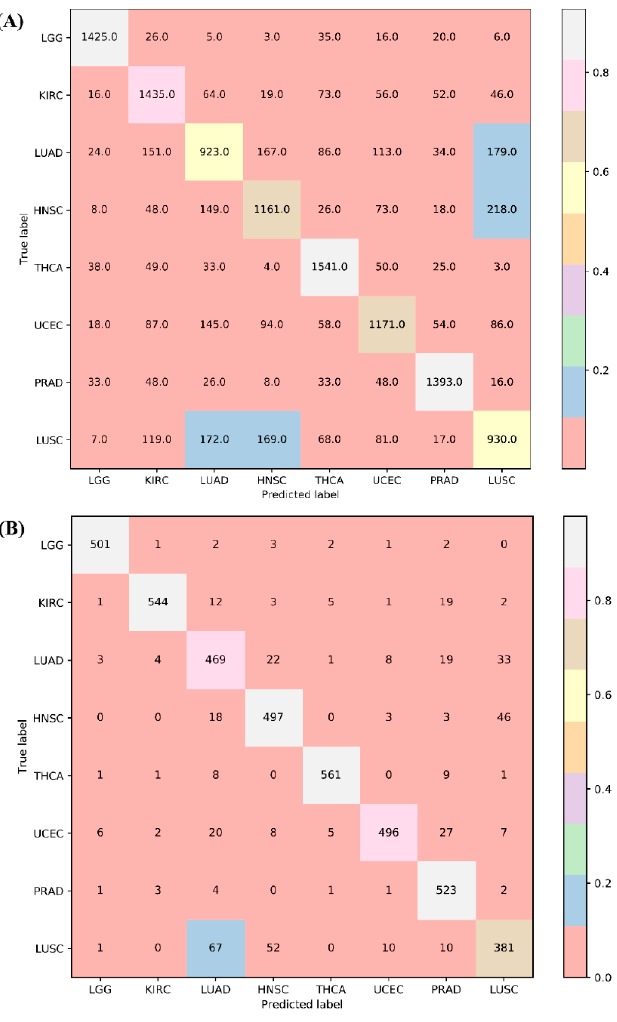
Figure 1. Confusion matrices for 10-fold cross-validation based on two classifiers. ( A ) The confusion matrix yielded by the 69 produced classification rules for classifying samples from 8 cancer types. The numbers were pooled by running 10-fold cross-validation on the training data thrice. ( B ) The confusion matrix yielded by the optimal support vector machine (SVM) classifier. The numbers were pooled by running 10-fold cross-validation on the training data once.